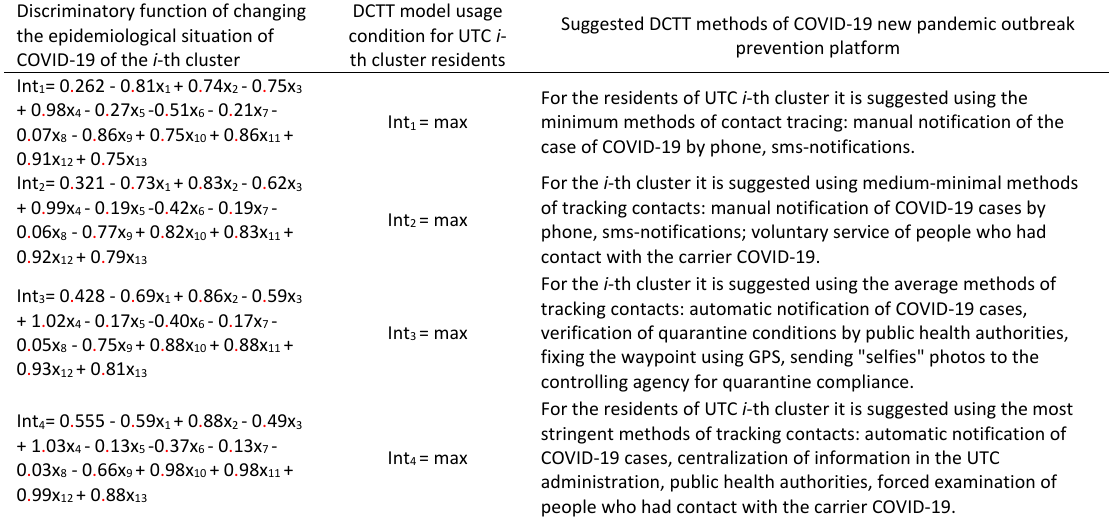
Тable 5: Results of discriminant analysis. Monitoring of changes in the epidemiological situation COVID-19 in rural areas of Sumy region (STATISTICA 10 listing) Discriminatory function of changing the epidemiological situation of COVID-19 of the i -th cluster